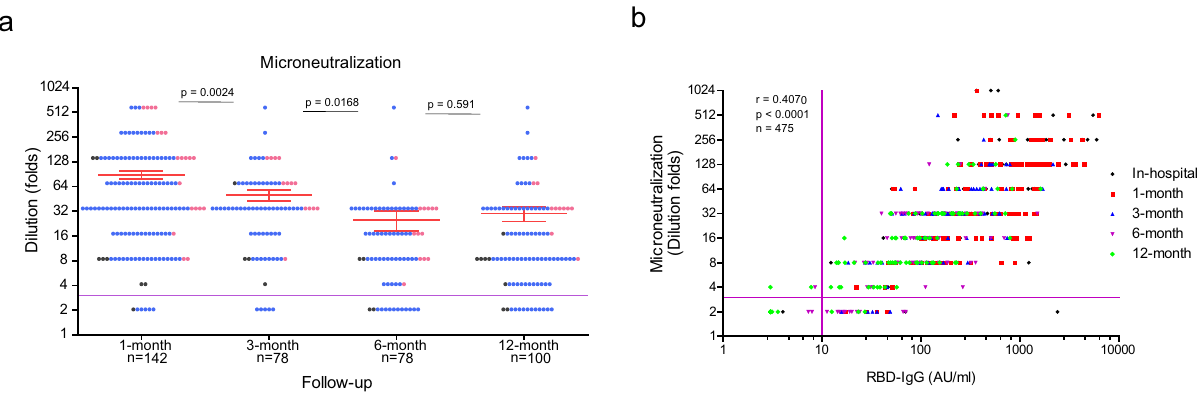
Fig. 2 Longitudinal analysis of serum protection against SARS-CoV-2 infection. Serum collected from multiple time points were tested against alive SARS-CoV-2 virus infection. a Microneutralization assay was performed using an alive SARS-CoV-2 infection cell culture system. y -axis, serum dilution folds. Data were presented as mean value ± SEM. Colored dots represent disease severity. Mild (blank dots), moderate (blue dots), and severe (red dots) symptoms. An unpaired t -test with Welch ’ s correction analysis was applied, and p values (two-tailed) were labeled. b Correlation of microneutralization (dilution folds) and RBD-IgG (arbitrary unit, AU/ml). A total of 475 pairs were analyzed, and Pearson r and p value (two-tailed) were shown. Lines in x -axis and y -axis in a and b indicate the cut-off values. Source data are provided as a Source Data fi